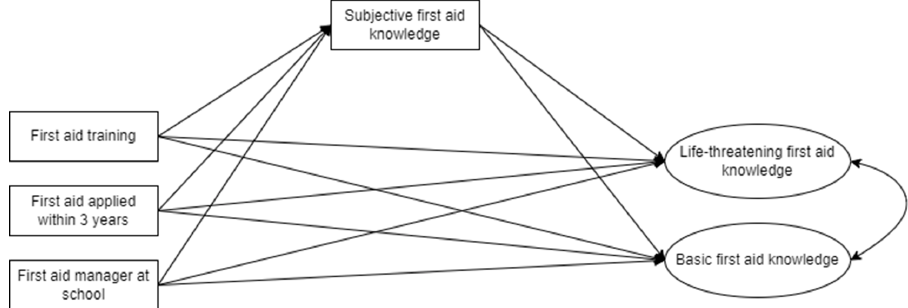
Figure 1. Schematic overview of the links between fi rst-aid indicators, subjective fi rst-aid knowledge, and objective fi rst-aid knowledge.